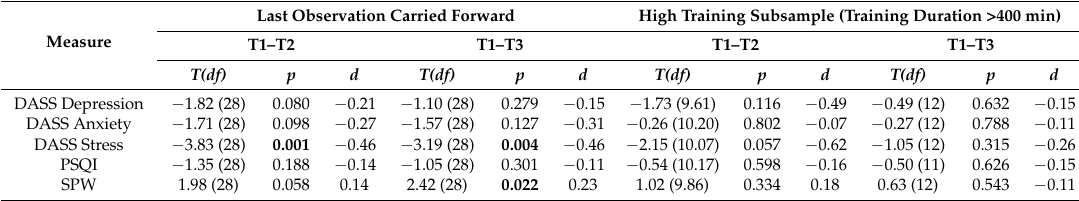
Table 4. Cohen’s d within-group effect sizes for stress and stress-related symptoms for participants in the HRV-biofeedback